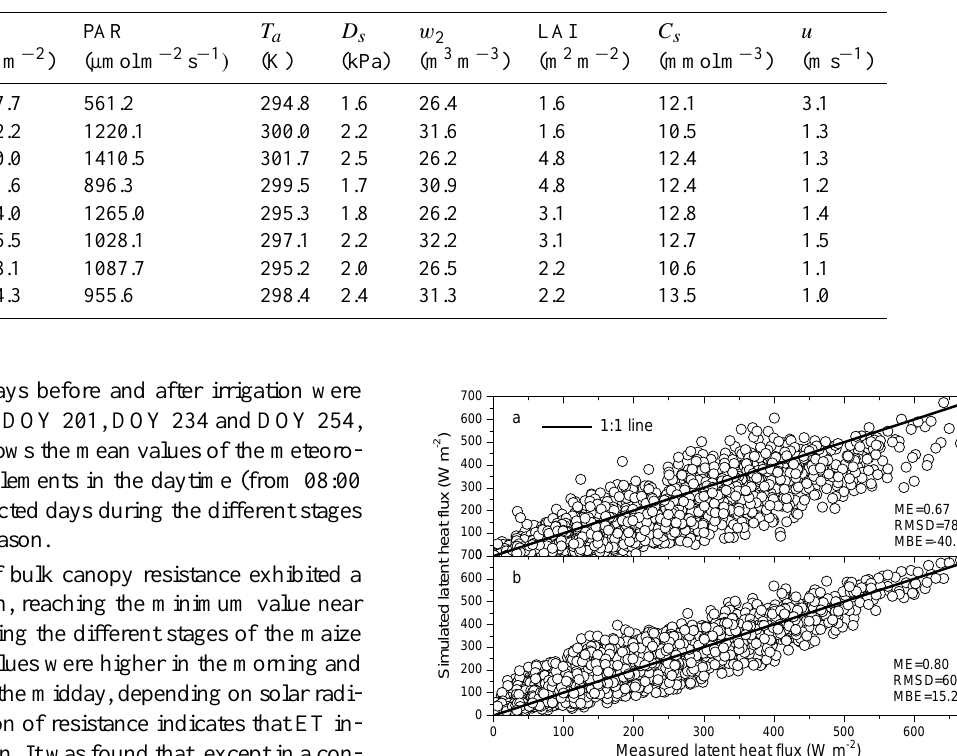
Table 3. Mean daytime meteorological and ecological elements on selected days before and after irrigation.